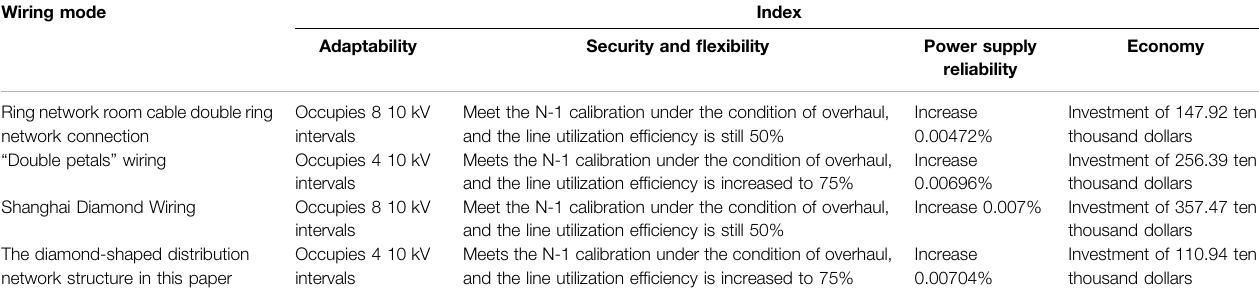
TABLE 3 | The effect of the four wiring mode transformation schemes. Wiring